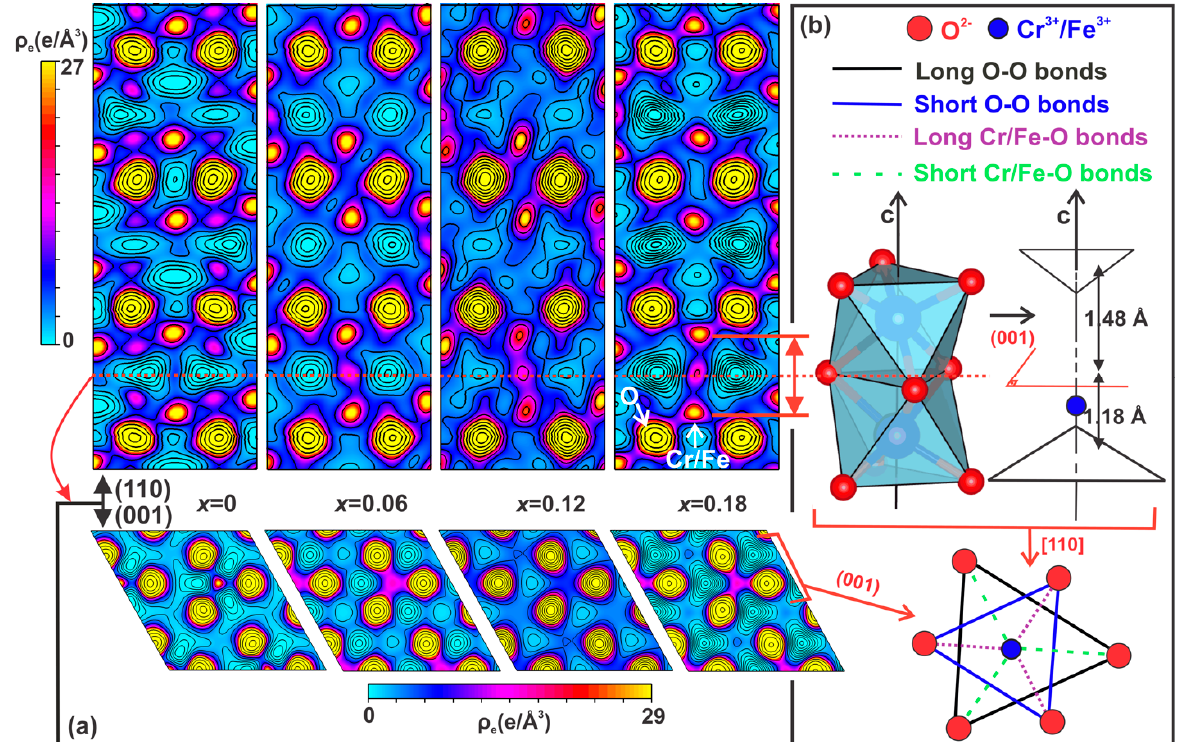
Figure 4. ( a ) Two-dimensional (2D) electron density maps drawn parallel to he (001) and (110) crystallographic planes obtained from MEM analyses for the Cr 2- x Fe x O 3 (0.0 ≤ x ≤ 0.18) nanoparticles. ( b ) Structural representations of chains of [CrO 6 ] dimers along the c -axis in the Cr 2 O 3 structure, highlighting the small and large equilateral triangles and Cr 3+ displacement from the octahedral site center (upper right-side sketch). The sketch below represents the two face-sharing FeO 6 octahedra, as shown in the upper right-side sketch, whereas there are three short and three long nearest-neighbor Fe/Cr–O distances inside each [Fe/Cr]O 6 octahedron.